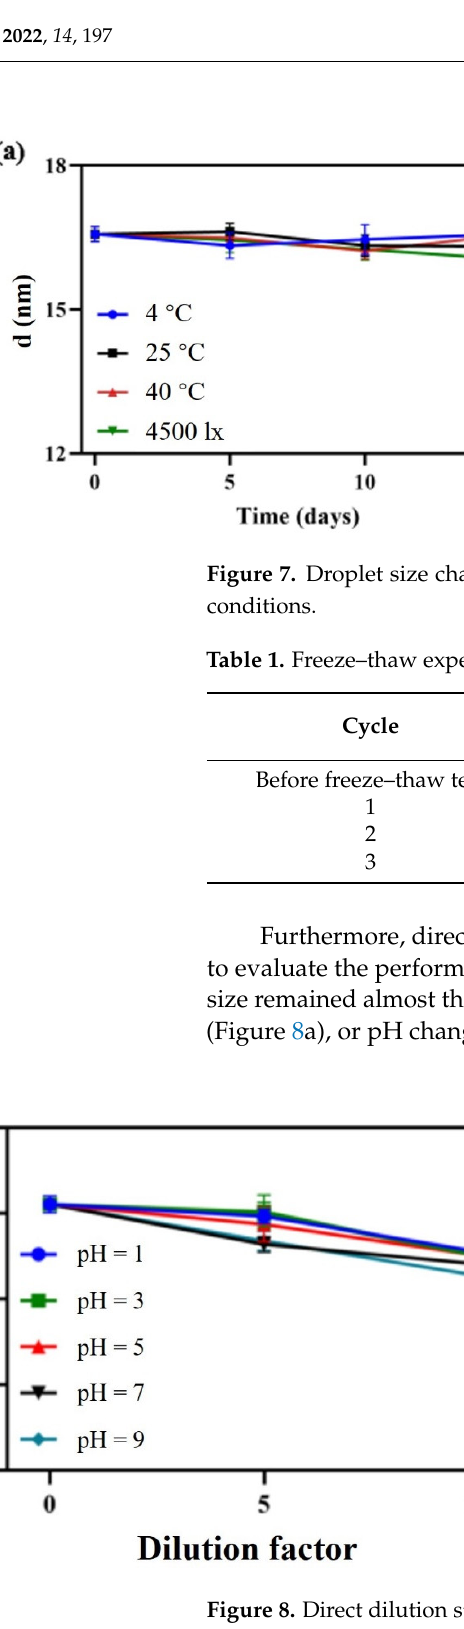
Figure 8. Direct dilution stability ( a ) and pH dynamic dilution stability ( b